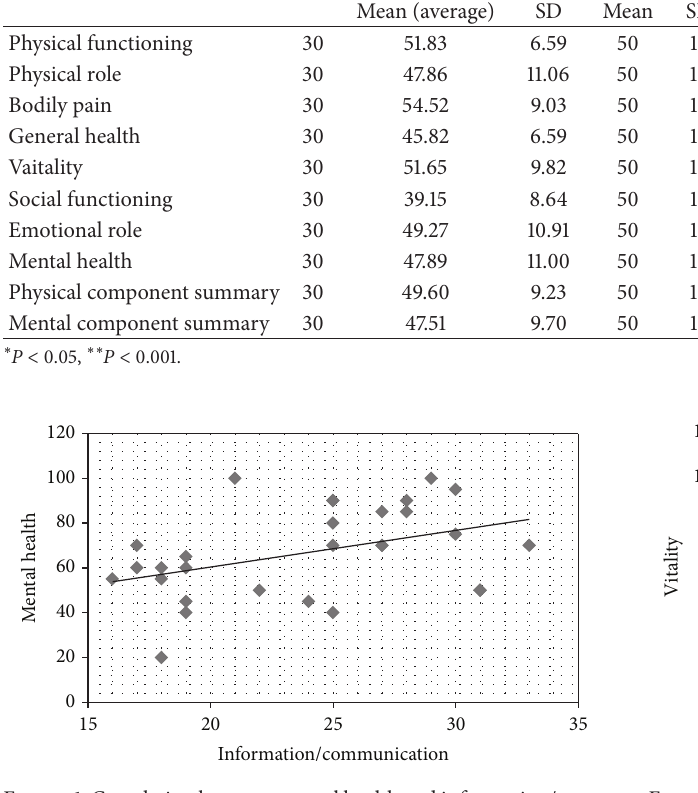
Figure 1: Correlation between mental health and information/com- munication. 𝑟 = 0.413 , 𝑃 = 0.026 .